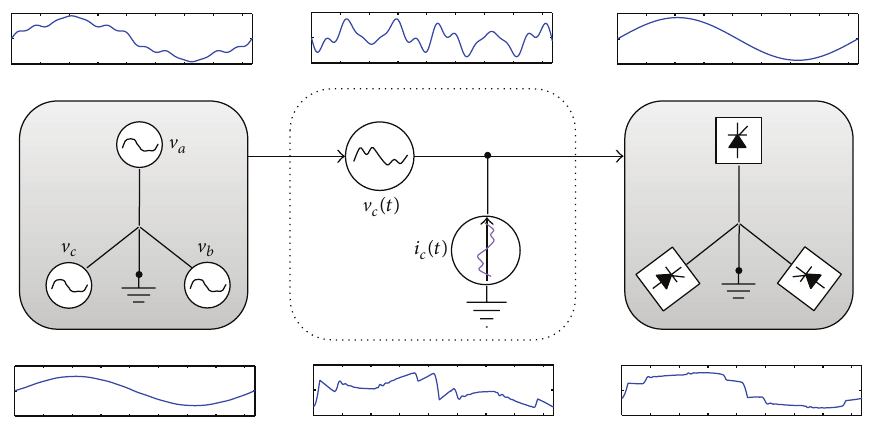
Figure 1: Classical scheme of compensation with the UPQC.